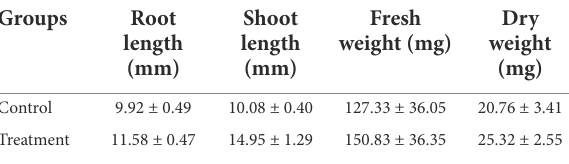
TABLE 7 Effect of FYN-22 strain on the growth of rice seedlings ( n = 20).